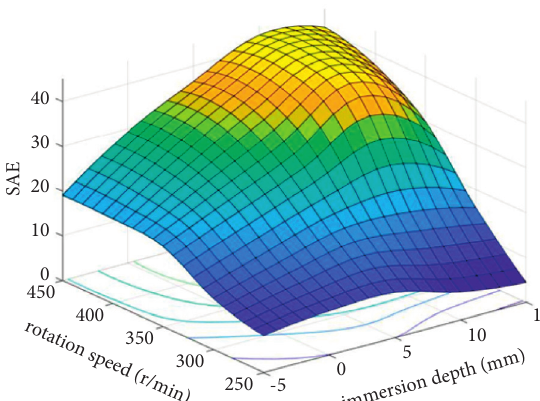
Figure 21: Standard power efficiency